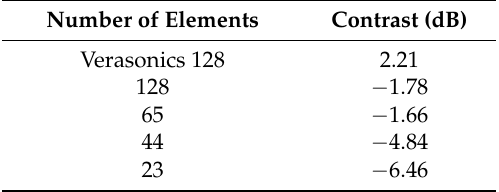
Table 8. Contrast from circular areas for the images shown in Figure 16.